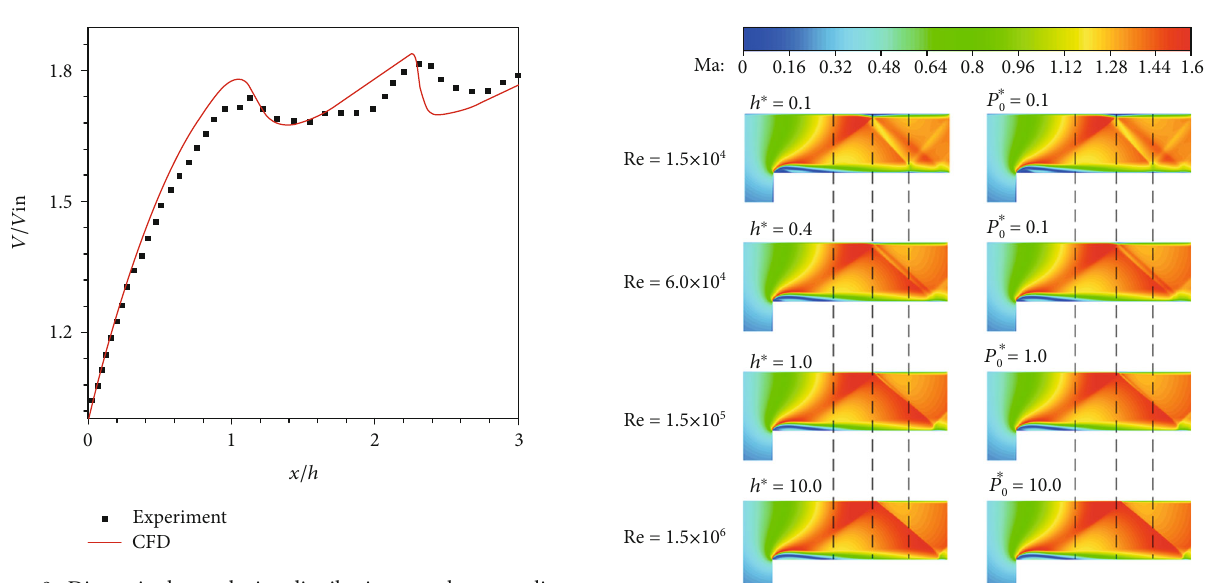
Figure 8: (a) Velocity contour and (b) Schlieren image obtained from the simulation ( w = 30 mm, h = 10 mm).